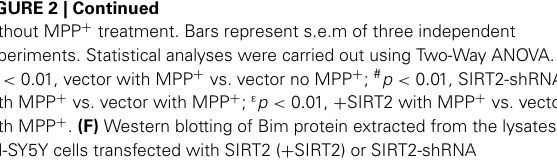
(SIRT2-shRNA) or empty vector (vector) with or without MPP + treatment. Quantification was carried out by densitometry using the NIH ImageJ program and is shown on the right. Three independent experiments were performed. Representative blot is shown. Statistical analyses were carried out using Two-Way ANOVA. ∗ p < 0 . 01, vector with 16h MPP + vs. vector no MPP + ; # p < 0 . 01, SIRT2-shRNA with 16h MPP + vs. vector with 16h MPP + ; ε p < 0 . 01, + SIRT2 with MPP + vs. vector with 16h MPP +